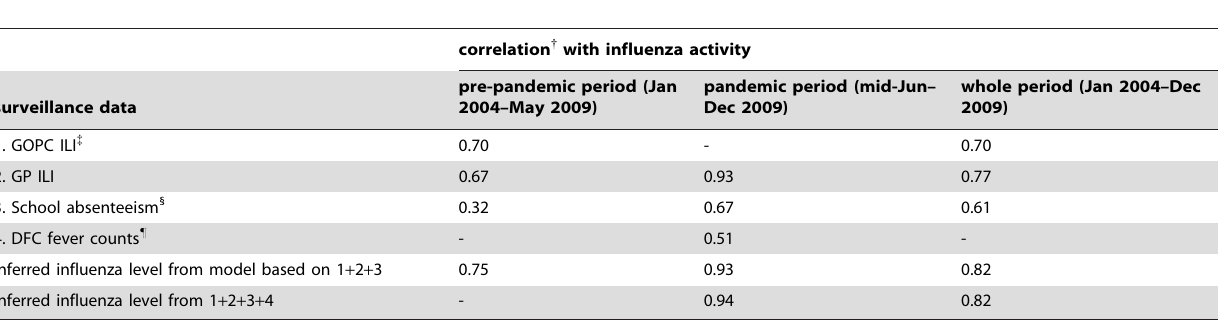
Table 1. Correlations of GOPC, GP ILI rate, school absenteeism, DFC fever counts and inferred influenza level from the dynamic linear model with the influenza activity * in pre-pandemic, pandemic and the whole period, January 2004–December 2009.